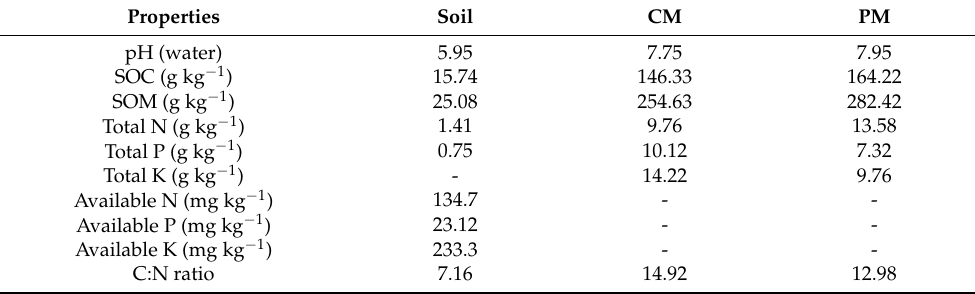
Figure 1. Mean monthly precipitation and air temperature during the experimental years. Table 1. Soil and manure chemical properties before the experimentation.